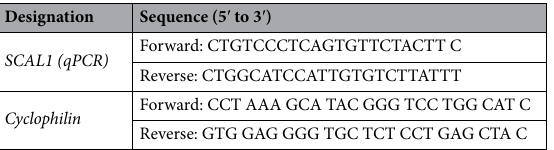
Table 1. Primers used in reverse transcription-quantitative PCR